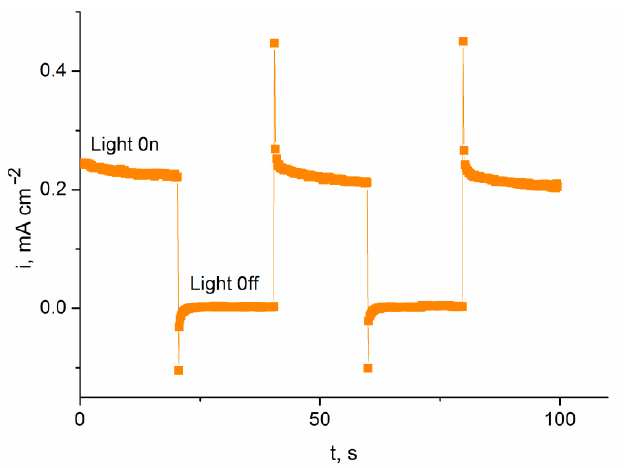
Figure 11. Photocurrent transients of a Ti 4+ /Fe 2 O 3 /FTO film photoanode measured in an aqueous solution of 0.1 M KOH + 0.01 mM 5,6,7,8-tetrahydro-2-naphthol at E = 0.4 V in dark conditions and under visible light illumination with a power density of 100 mW cm − 2 .